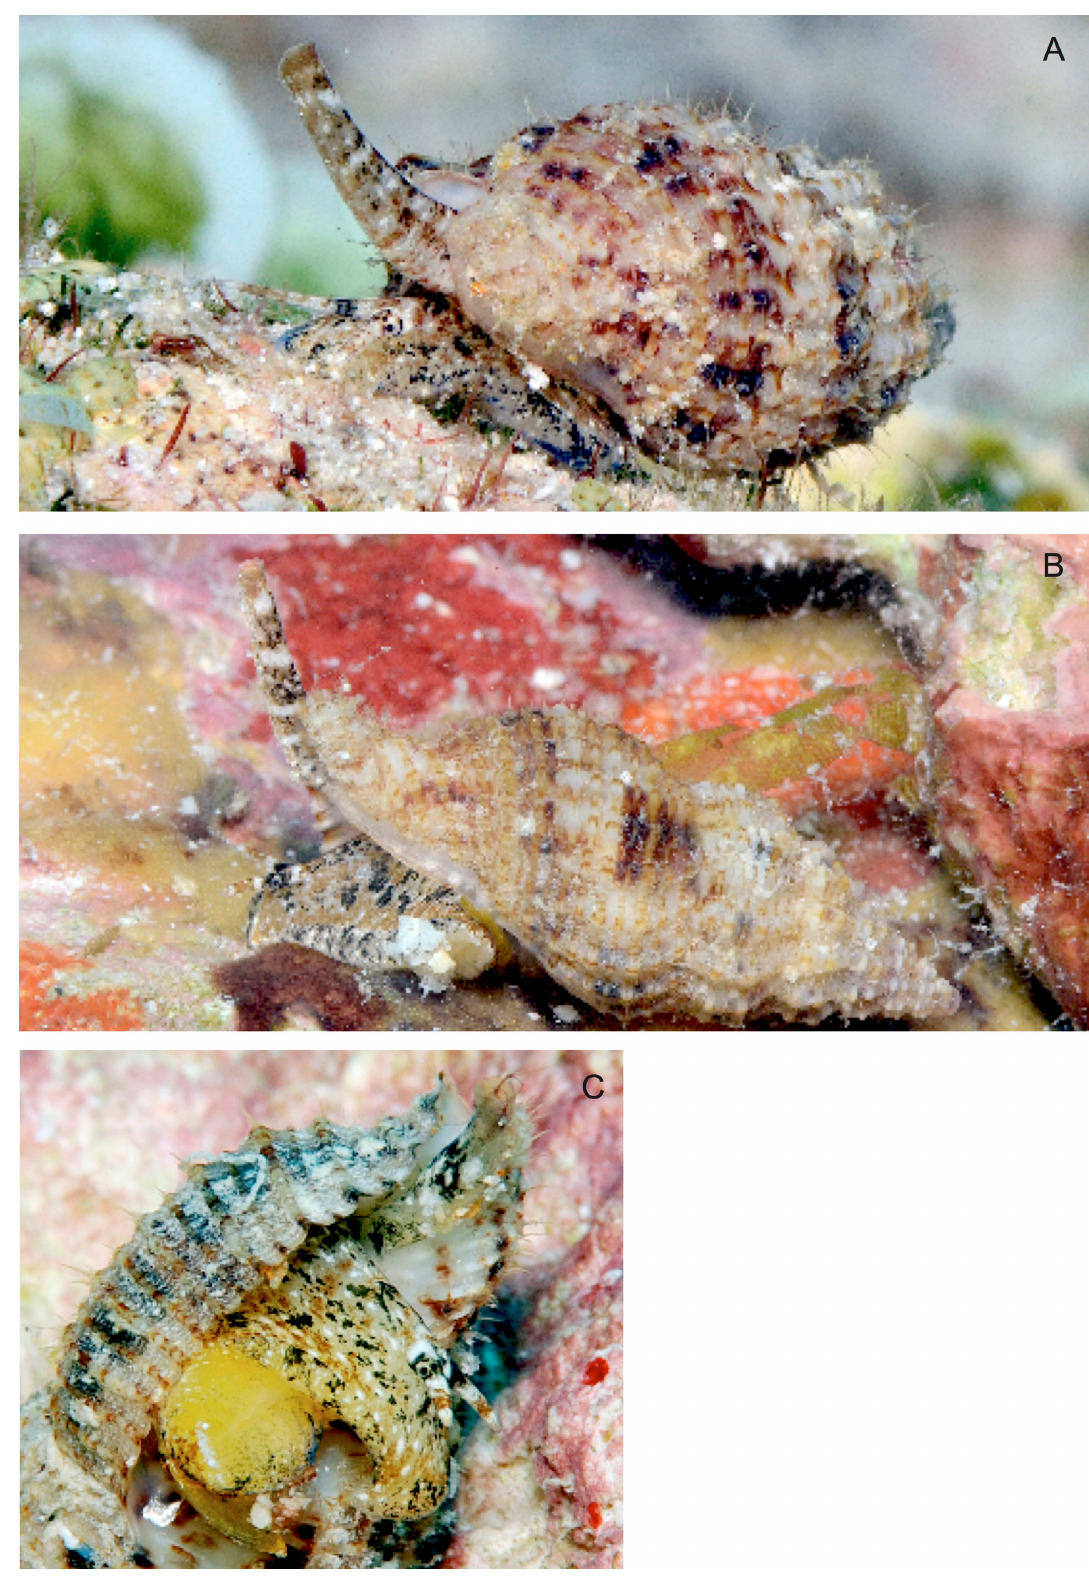
Fig. 2A–C. Sinetectula egregia (Reeve, 1844) gen. et comb. nov., in situ, Marshall Islands, Kwajalein Atoll, images courtesy of Jeanette Johnson, © 2015 In-Depth Images